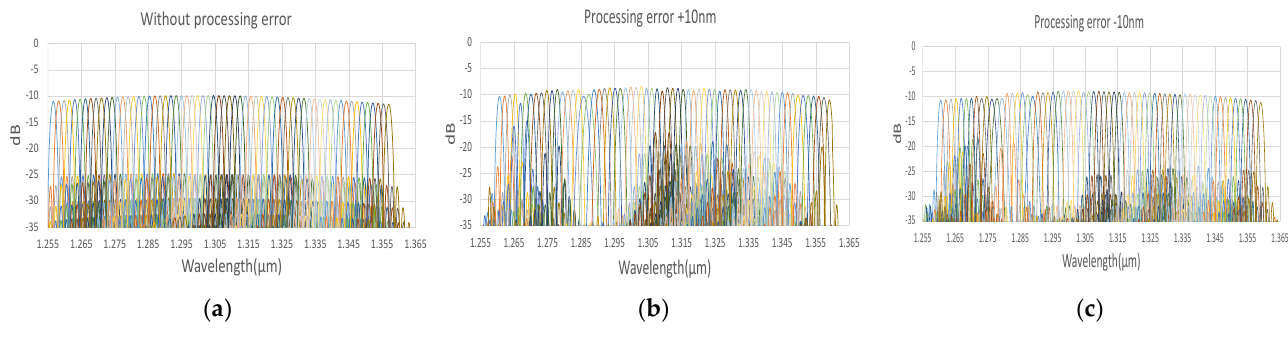
Figure 9. The simulated spectrum response for the AWG ( a ) without the process length shift; ( b ) at 10 nm waveguide width shift; ( c ) at − 10 nm waveguide width variation. Different color lines represent individual wavelength output channels.